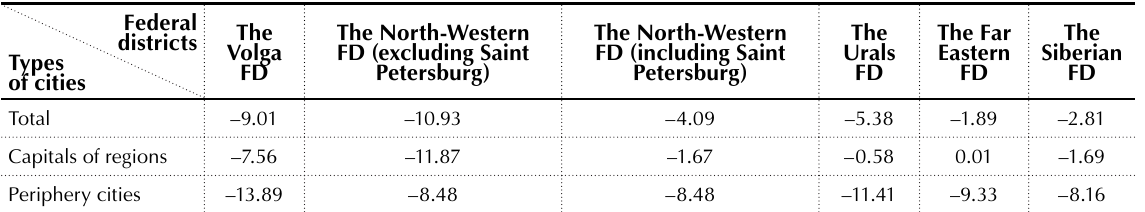
Table 1. Changes in the number of employees in organizations in 2009–2015, %